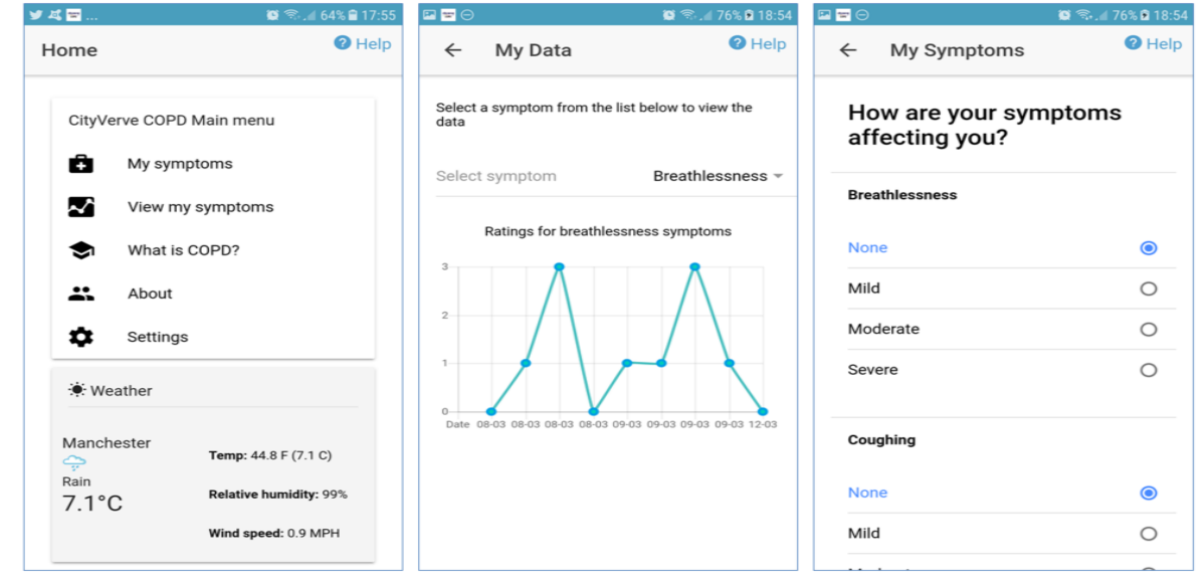
Figure 1. Screenshots of app: (left) home/landing page with the main menu and weather widget (center) graph showing ratings for breathlessness symptom and (right) self-reported impact of